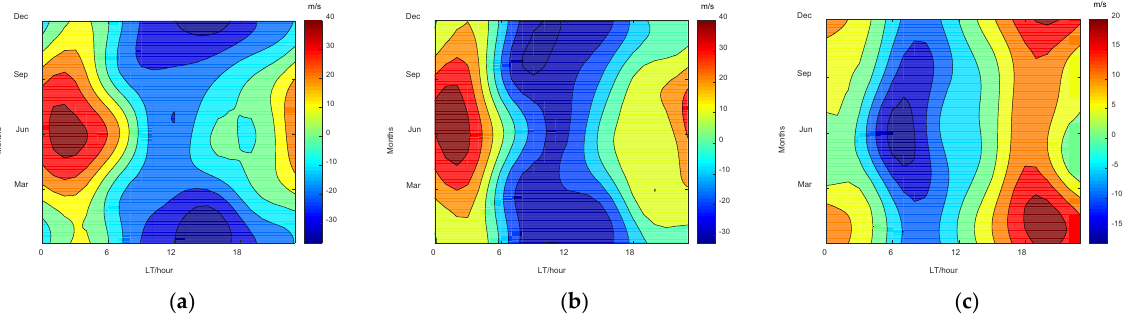
Figure 6. ( a ) Vertical drift velocity in 60°E, 47.5°N; ( b ) Vertical drift velocity in 135°E, 47.5°N; ( c ) Vertical drift velocity difference between them.